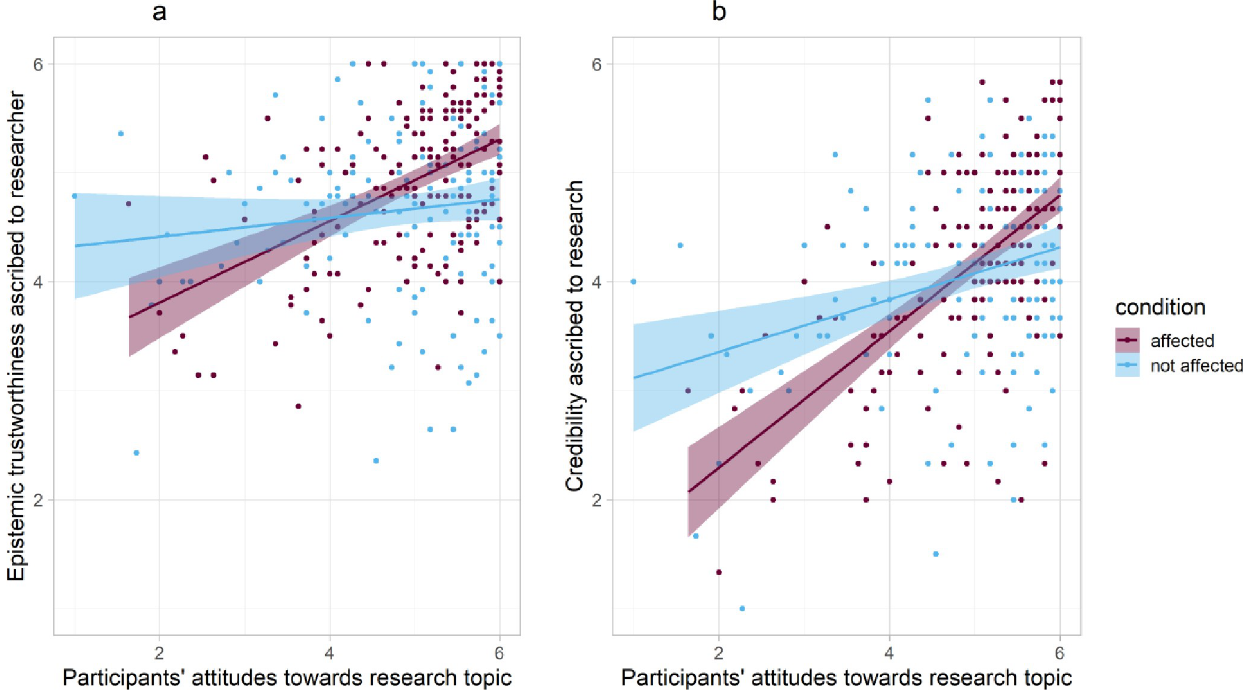
Fig 1. Linear regression plots for the interaction effect of attitudes × condition on epistemic trustworthiness (Fig 1A) and credibility (Fig 1B) with 95% confidence intervals: Participants’ attitudes towards the research topic moderated how a researcher’s disclosure of being personally affected (vs. being not personally affected) by one’s own research was